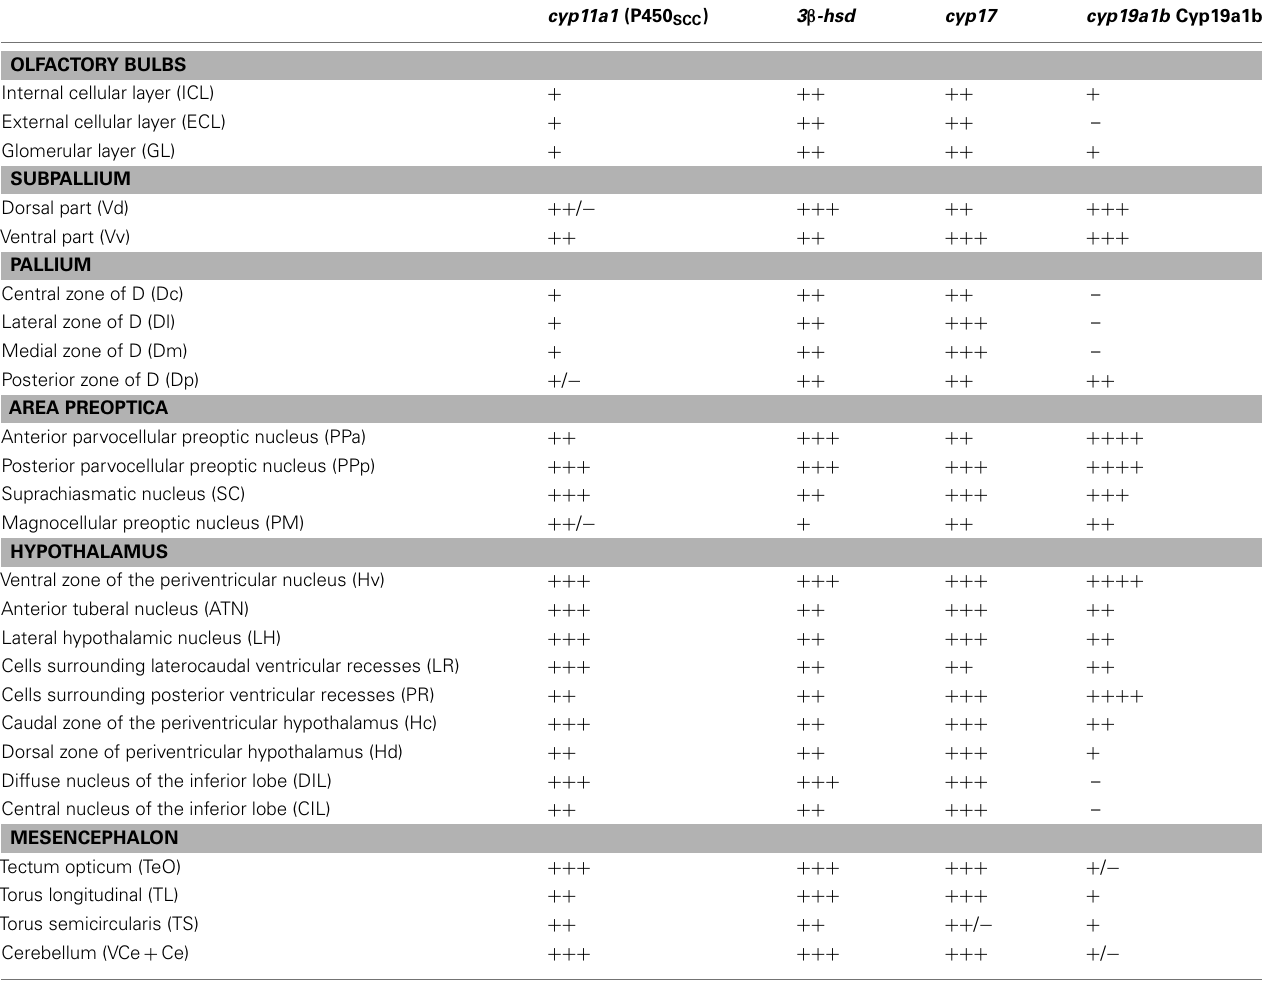
Table 1 | Distribution and relative abundance of cyp11a1 , 3 β -hsd , cyp17, and cyp19a1b mRNAs in the brain of adult